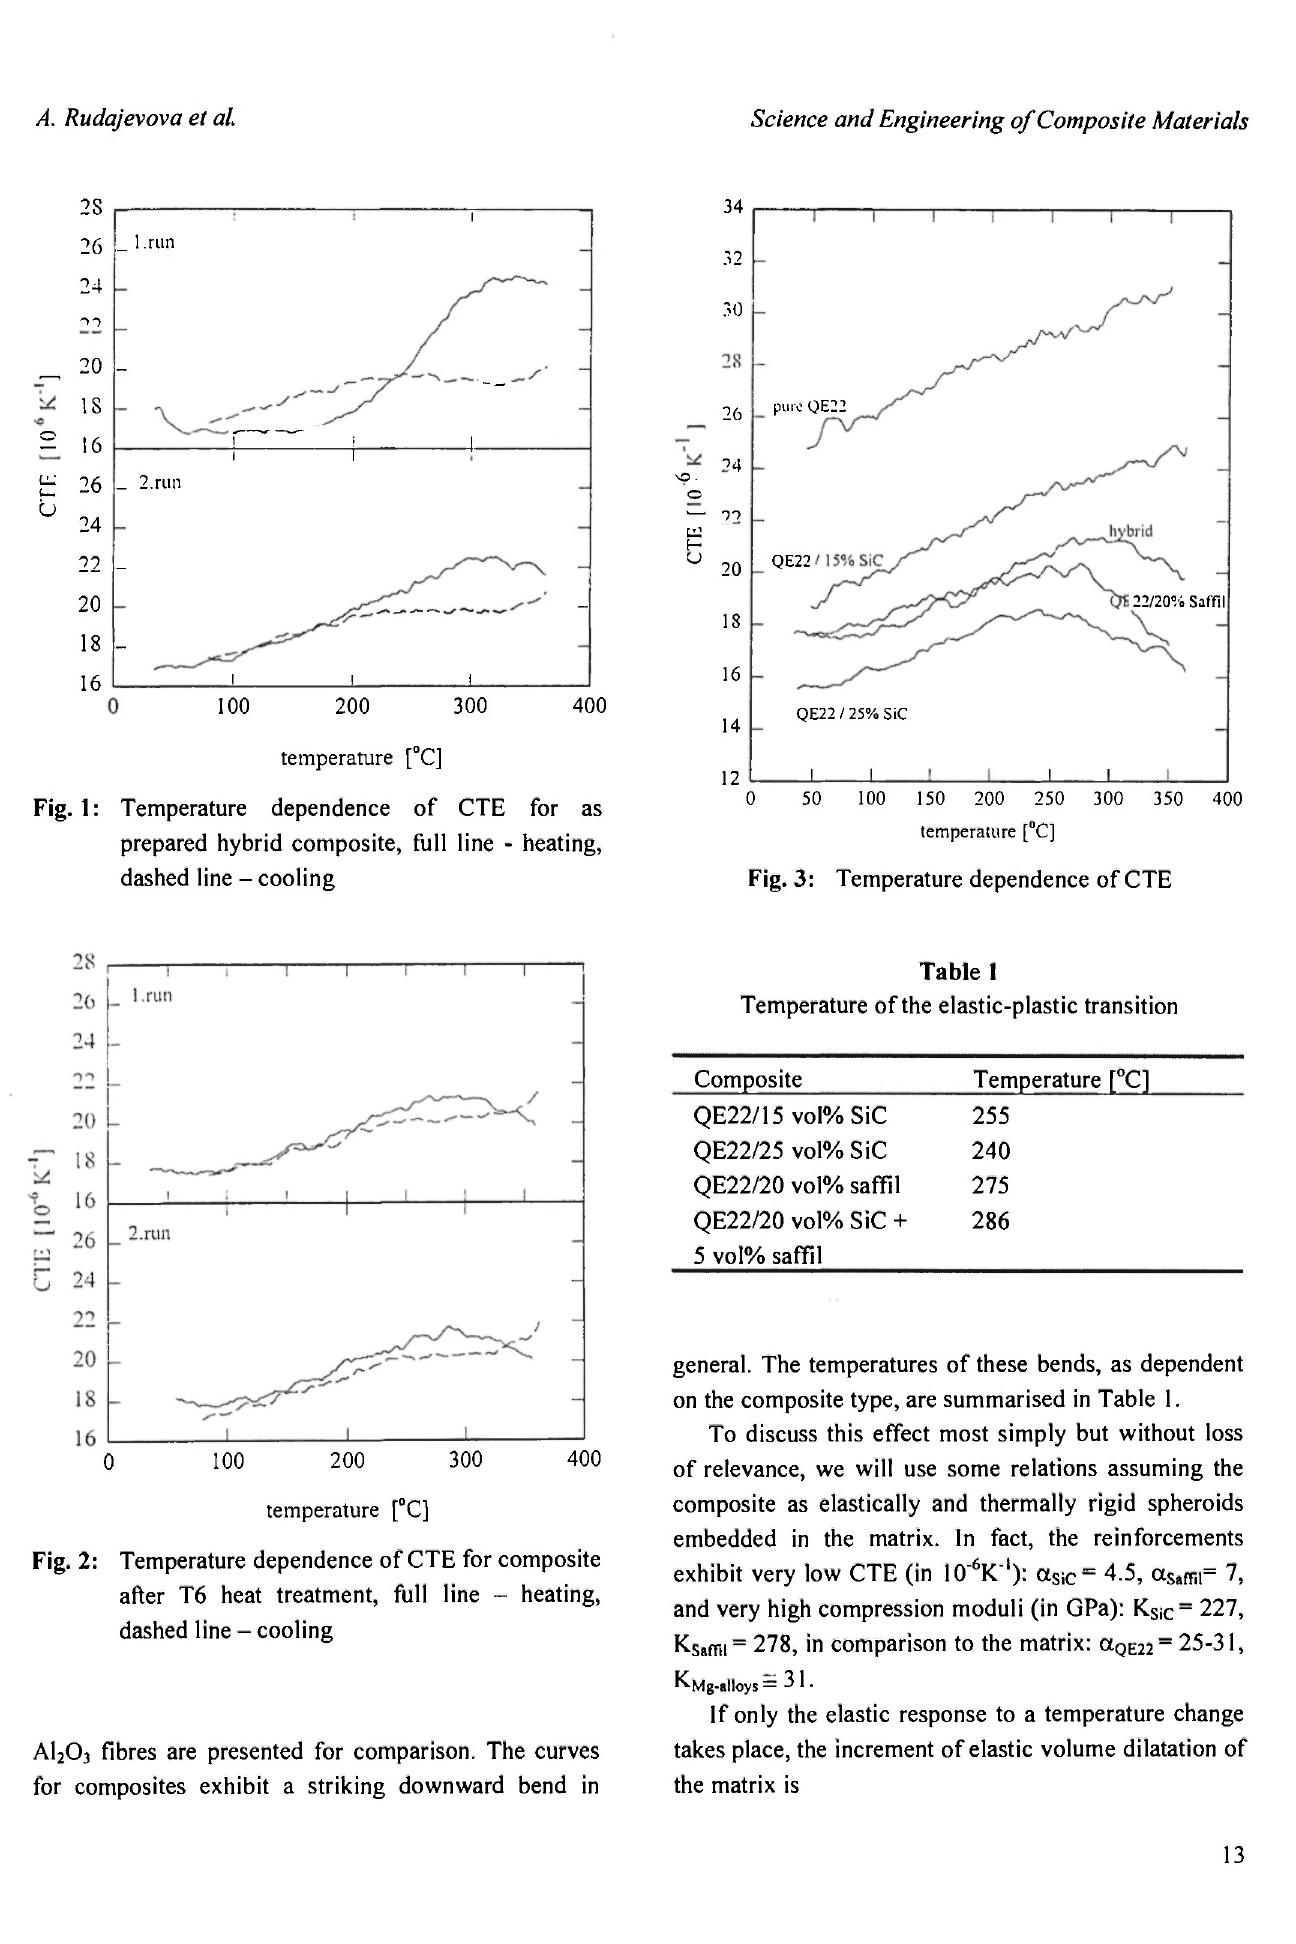
4.5, a Sa fiii = 7,